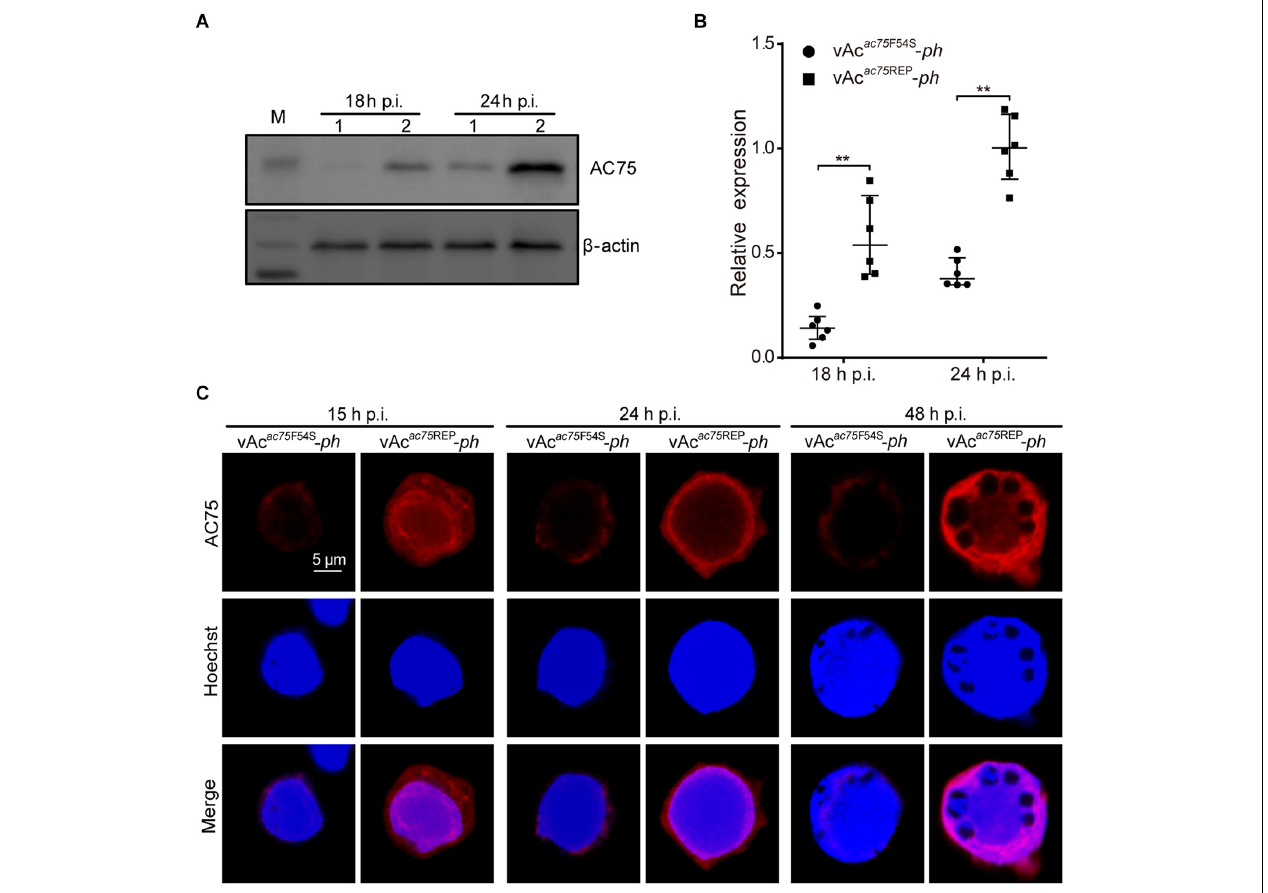
FIGURE 7 | Expression and localization of AC75 in vAc ac 75 F 54 S - ph - or vAc ac 75REP - ph -infected cells. (A) Western blot analysis. Sf9 cells infected with vAc ac 75 F 54 S - ph or vAc ac 75REP - ph at an MOI of 5 were harvested and lysed at 18 and 24 h p.i. The lysates were subjected to western blot using anti-AC75 and anti-actin (control) as primary antibodies. Lane 1, vAc ac 75 F 54 S - ph ; Lane 2, vAc ac 75REP - ph . (B) Relative quantification of the expression levels of AC75 by densitometry analysis of western blot. Each dot represents the expression level in one independent experiment relative to the mean for AC75 in vAc ac 75REP - ph -infected cells at 24 h p.i. The values represent the averages from six independent assays and error bars represent SD. ** indicates P < 0.01. (C) Immunofluorescence analysis of localization and expression of AC75. Sf9 cells infected with vAc ac 75 F 54 S - ph or vAc ac 75REP - ph at an MOI of 5 were fixed at the indicated time points. The cells were incubated with an anti-AC75 antibody (red). The nuclei were stained with Hoechst 33258